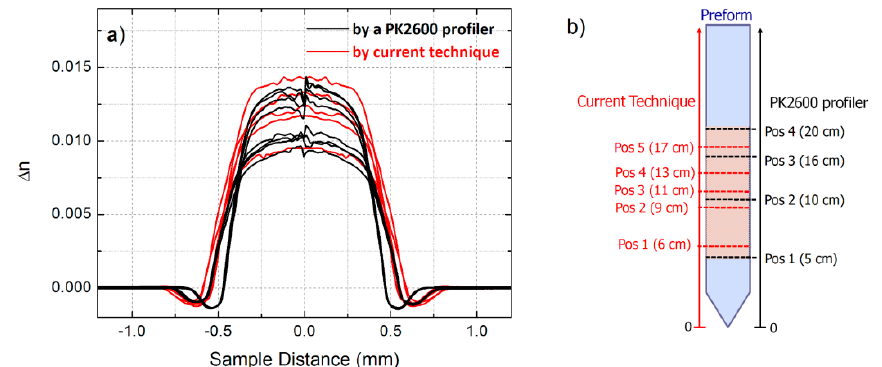
Figure 5. ( a ) Comparison between the refractive index profiles obtained using the current technique (solid red curves) and the ones obtained using PK 2600 (solid black curves) in different preform positions according to the scheme reported in ( b ). For the PK2600 profiler, each measurement was performed at two different angles (0° and 90°).